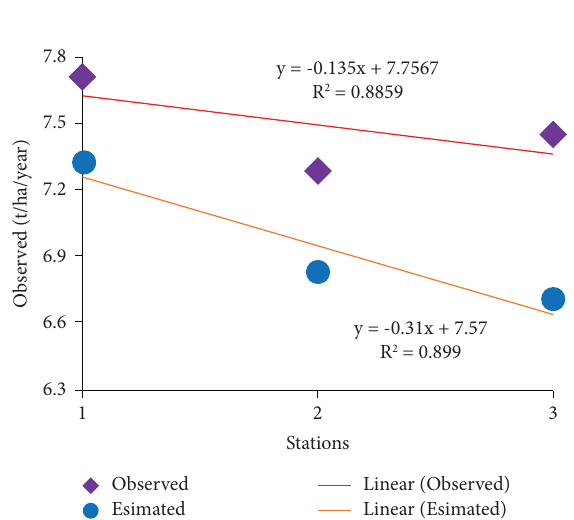
Figure 11: Observed and predicted soil erosion in the